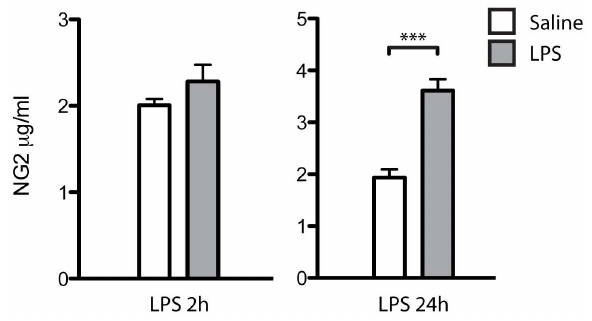
Figure 3. Levels of sNG2 in CSF from rats 2 h and 24 h after LPS treatment. Levels of CSF sNG2 were not significantly altered 2 h after LPS treatment compared to saline treatment (Saline), but 24 h after LPS treatment CSF sNG2 levels were significantly increased compared to saline treatment.*** indicates a significant difference at p , 0.001 level.